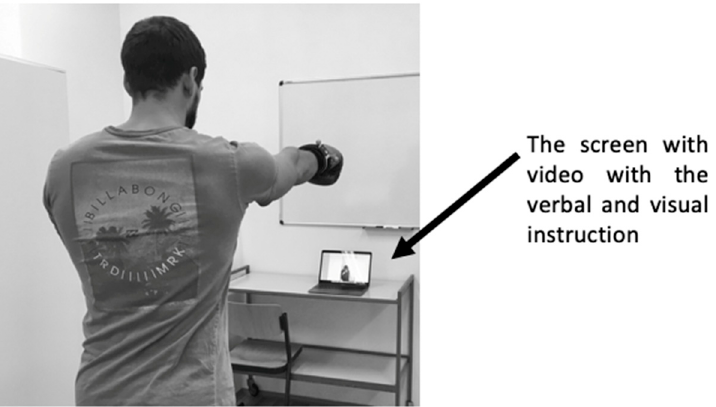
Figure 2. Instructional video: the participant stood in front of the screen with the video with verbal and visual instructions. and visual